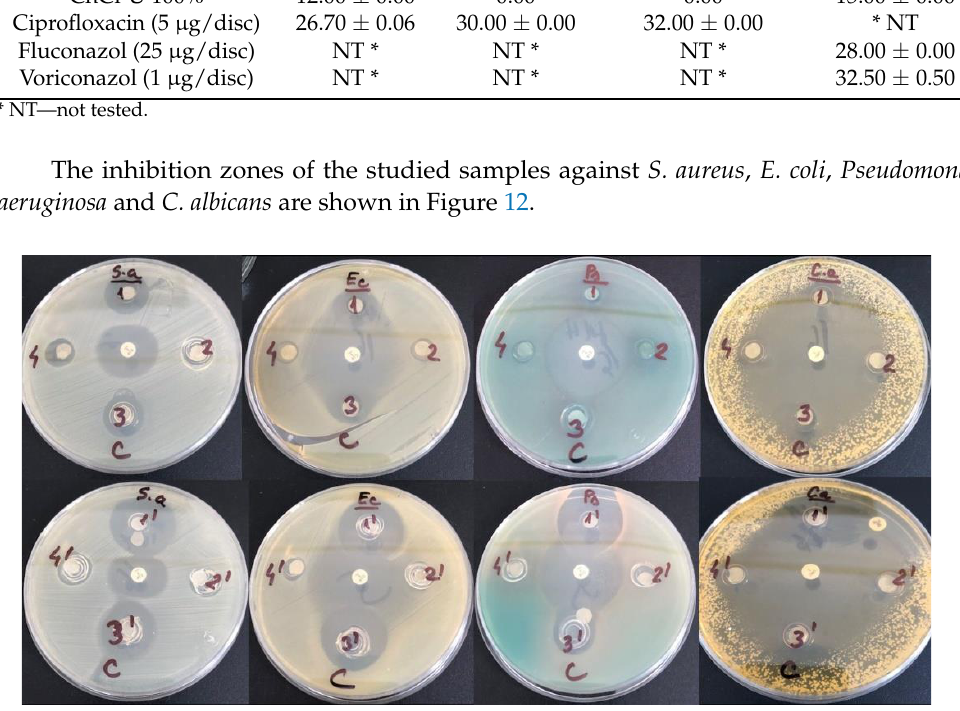
Figure 12. Antimicrobial activity of tested compounds HPC-ChCl-CA 29% (1) and ChCl-CA 100% (1 ′ ); HPC-ChCl-Gly 29% (2) and ChCl-Gly 100% ( 2′ ); HPC-ChCl-LA 29% (3) and ChCl-LA 100% ( 3′ ); HPC-ChCl-U 29% (4) and ChCl-U 100% ( 4′ ) against Staphylococcus aureus ATCC 25923, E. coli ATCC 25922, Pseudomonas aeruginosa ATCC 27853 and Candida albicans ATCC 90028.